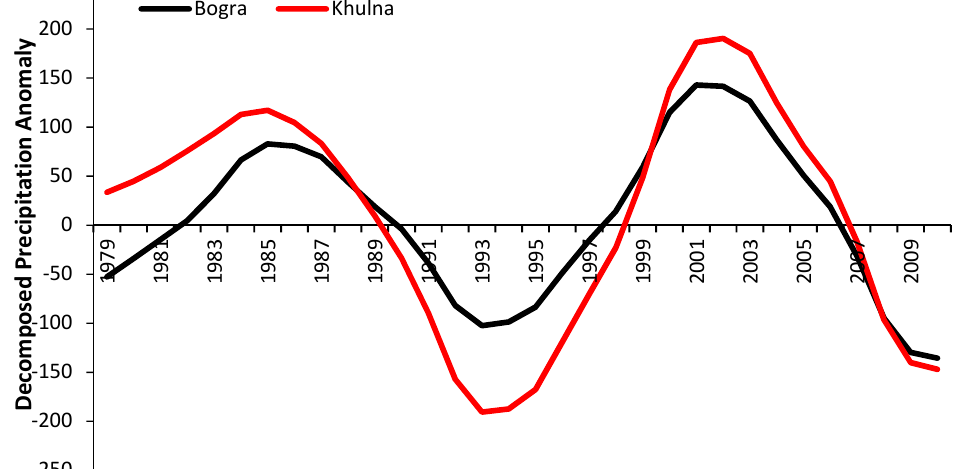
Figure 6. Plots of the autocorrelation function of the annual rainfall of Bangladesh for the period 1979–2010 at: ( a ) Bogra, in the north; and ( b ) Khulna, in the south.